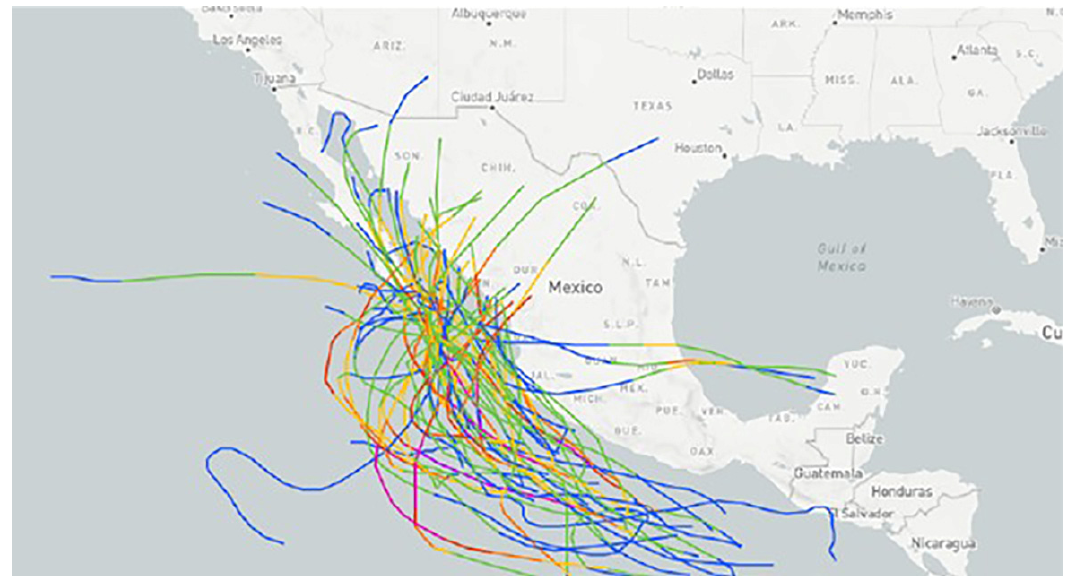
Figure 7. Tracks of tropical storms that passed along the GC region from 1980 to 2019. Source: National Oceanic and Atmospheric Administration (2020). Table 4. Number of tropical depressions (td), tropical storms (ts) and hurricanes (h) category 1 to 5 making landfall in the GC during the period 1980–2019. Source: National Oceanic and Atmospheric Administration (2020).